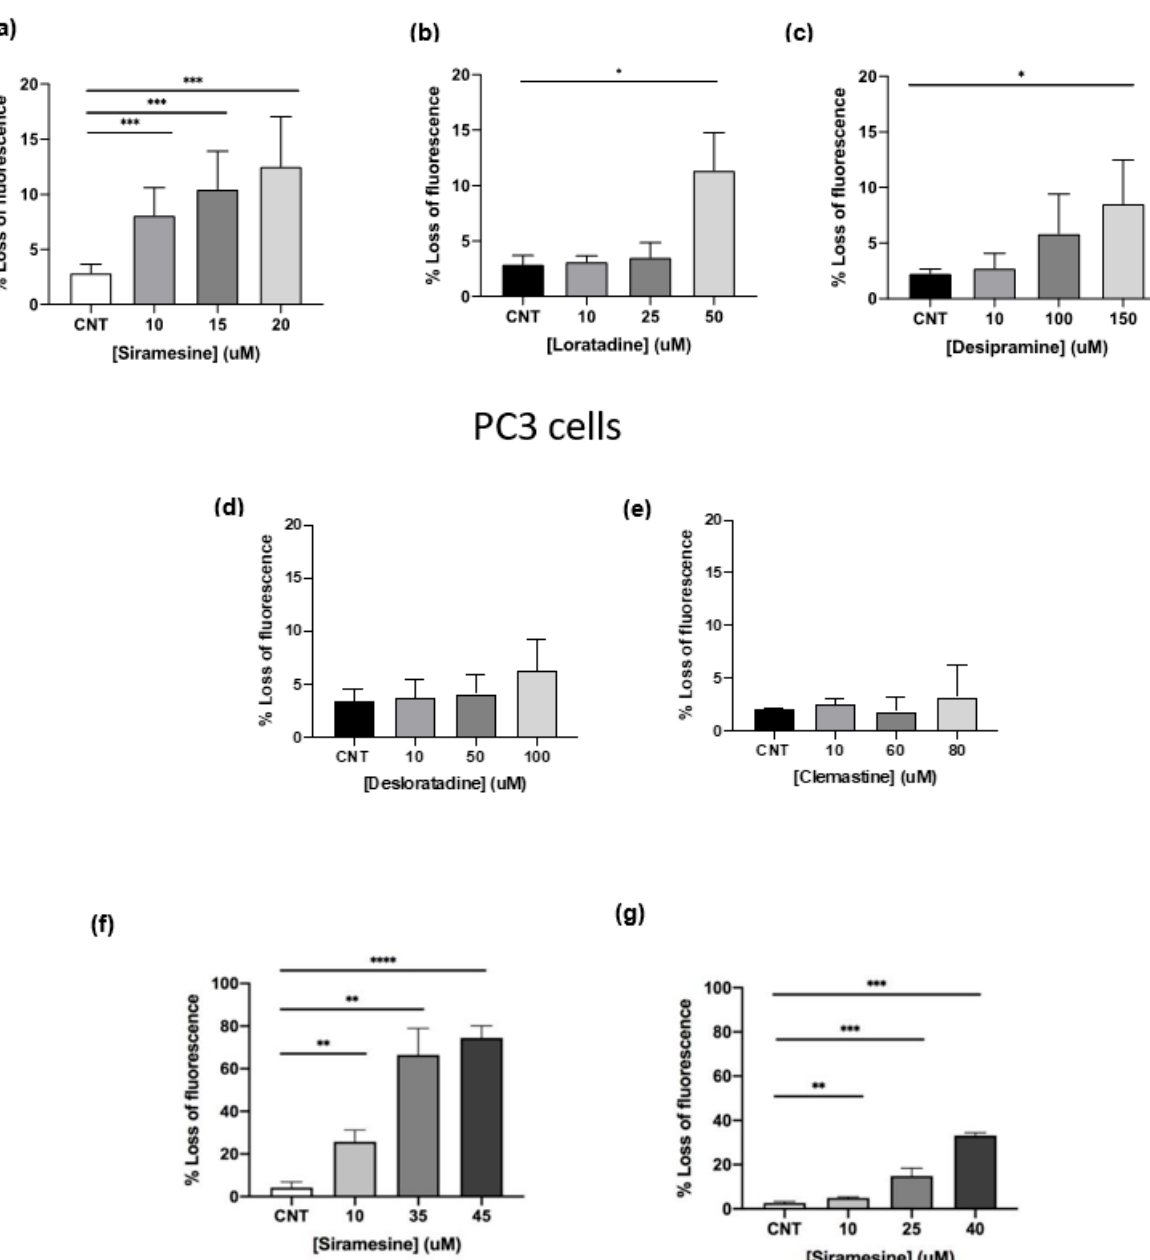
Figure 1. Lysosomotropic agents induce lysosome membrane permeabilization at 4 h in PC3 cells. PC3 cells were treated with ( a ) siramesine, ( b ) loratadine, ( c ) desipramine, ( d ) desloratadine and ( e ) clemastine for 4 h and stained with the fluorescent dye Lysotracker (50 nM) and analyzed by flow cytometry. A decrease in fluorescence indicates an increase in LMP. ( f ) DU145 and ( g ) LNCaP cells were treated with increasing doses of siramesine for 4 h and stained with the fluorescent dye Lysotracker (50 nM) and analyzed by flow cytometry. Decrease in fluorescence indicates an increase in LMP. Results are representative of at least three independent replicates ( n = 3). A p -value < 0.05 was considered statistically significant (represented by *) in addition to a p -value < 0.01 (represented by **), and a p -value < 0.001 (represented by ***)